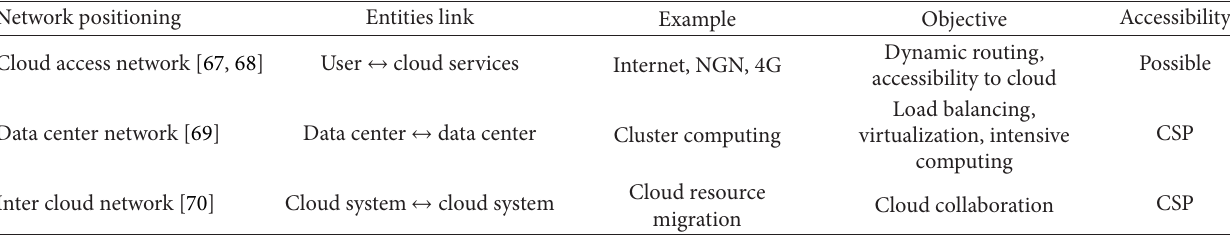
Table 1: Generalized network positions in MCC.